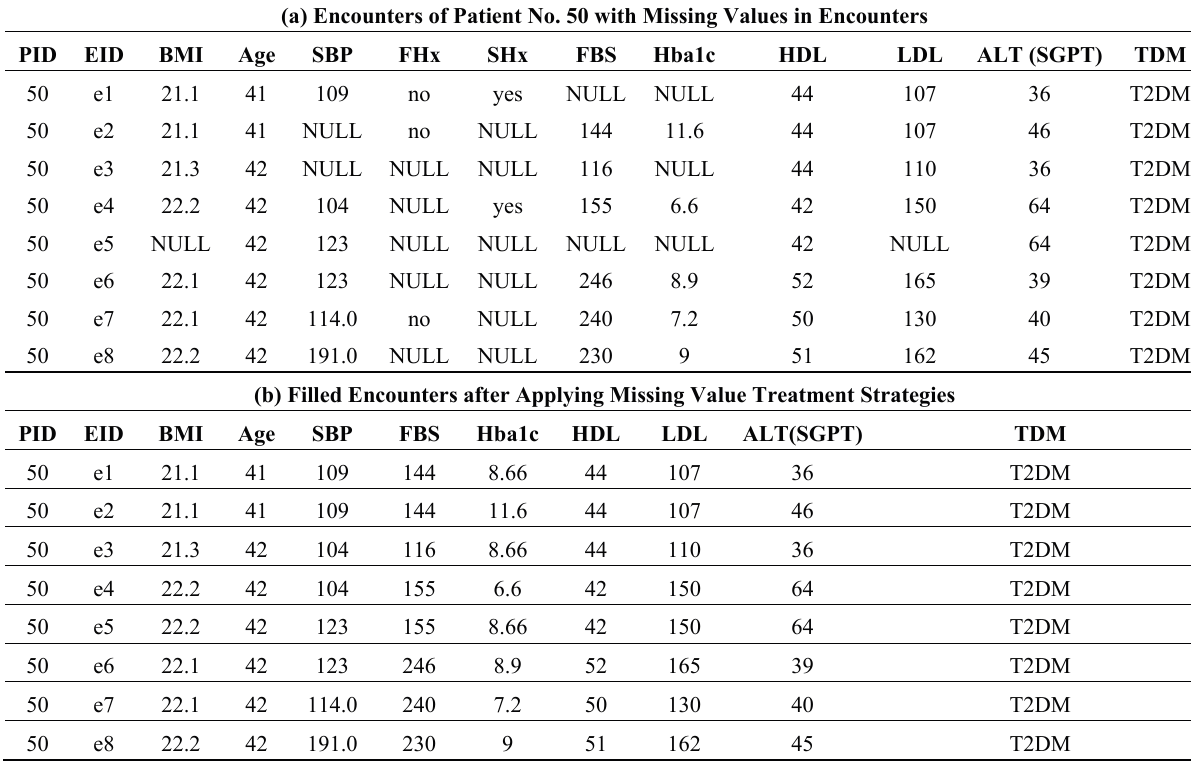
Table A1. Encounters of a single patient before and after applying the missing value completion